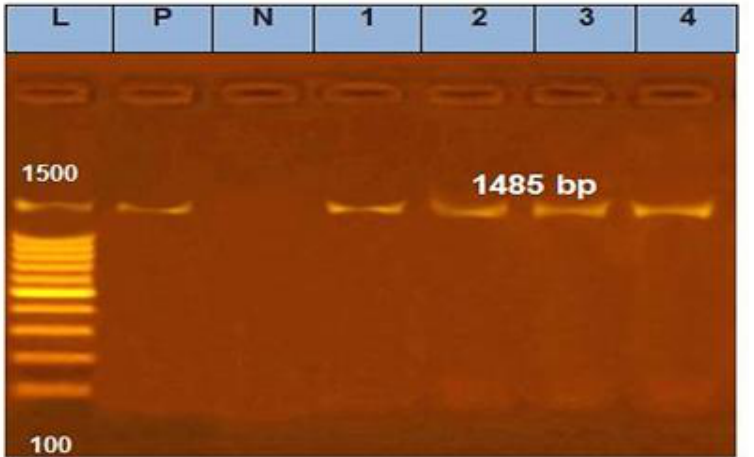
Figure 1. Gel electrophoresis of four bacterial isolates ( 16S rRNA amplicon) from fermented boza and cider treatments including (L) marker, (P) Positive control Lactobacillus plantarum , (N) Negative control (1: boza A3; 2: fermented cider, fridge (B6); 3: fermented cider, ambient (C9); 4: unfermented cider (D6).